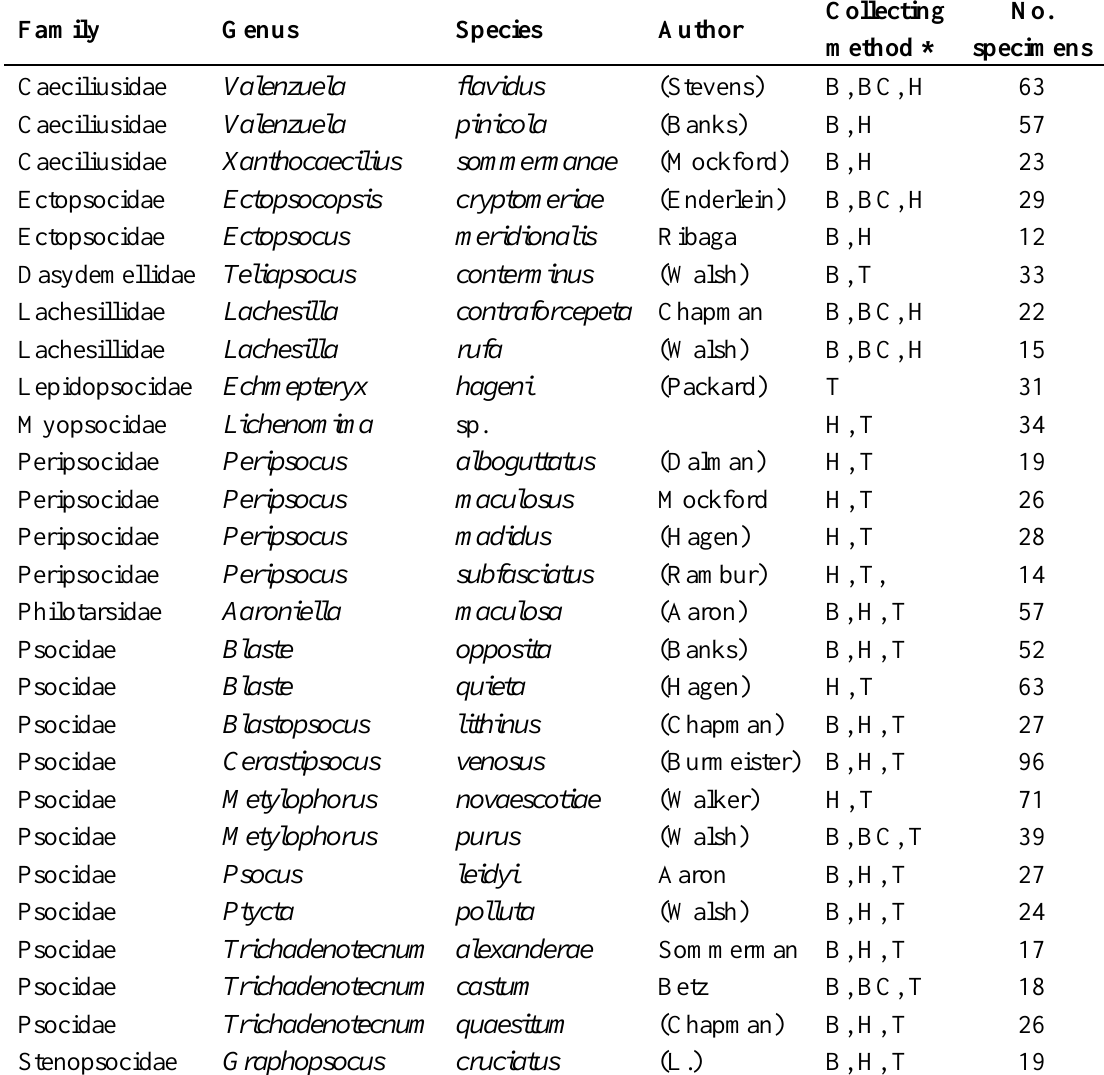
Table 1. Vertically sampled Psocoptera species associated with eastern hemlock in the southern Appalachians and corresponding collection